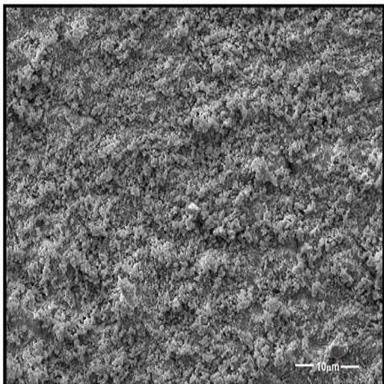
Micrograph of GC5 composition.